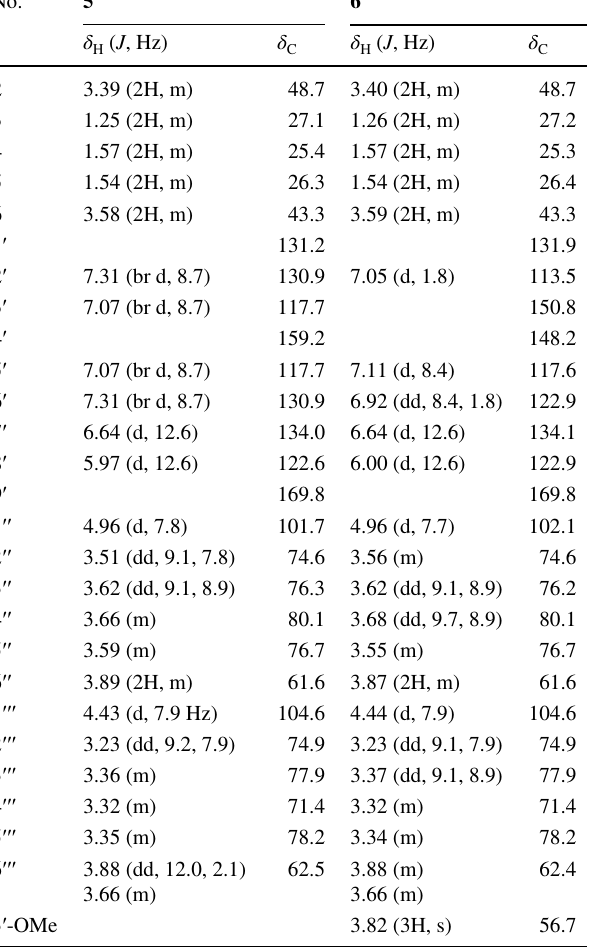
Table 3 1 H (800 MHz) and 13 C NMR (201 MHz) data of 5 and 6 in methanol- d 4 No.